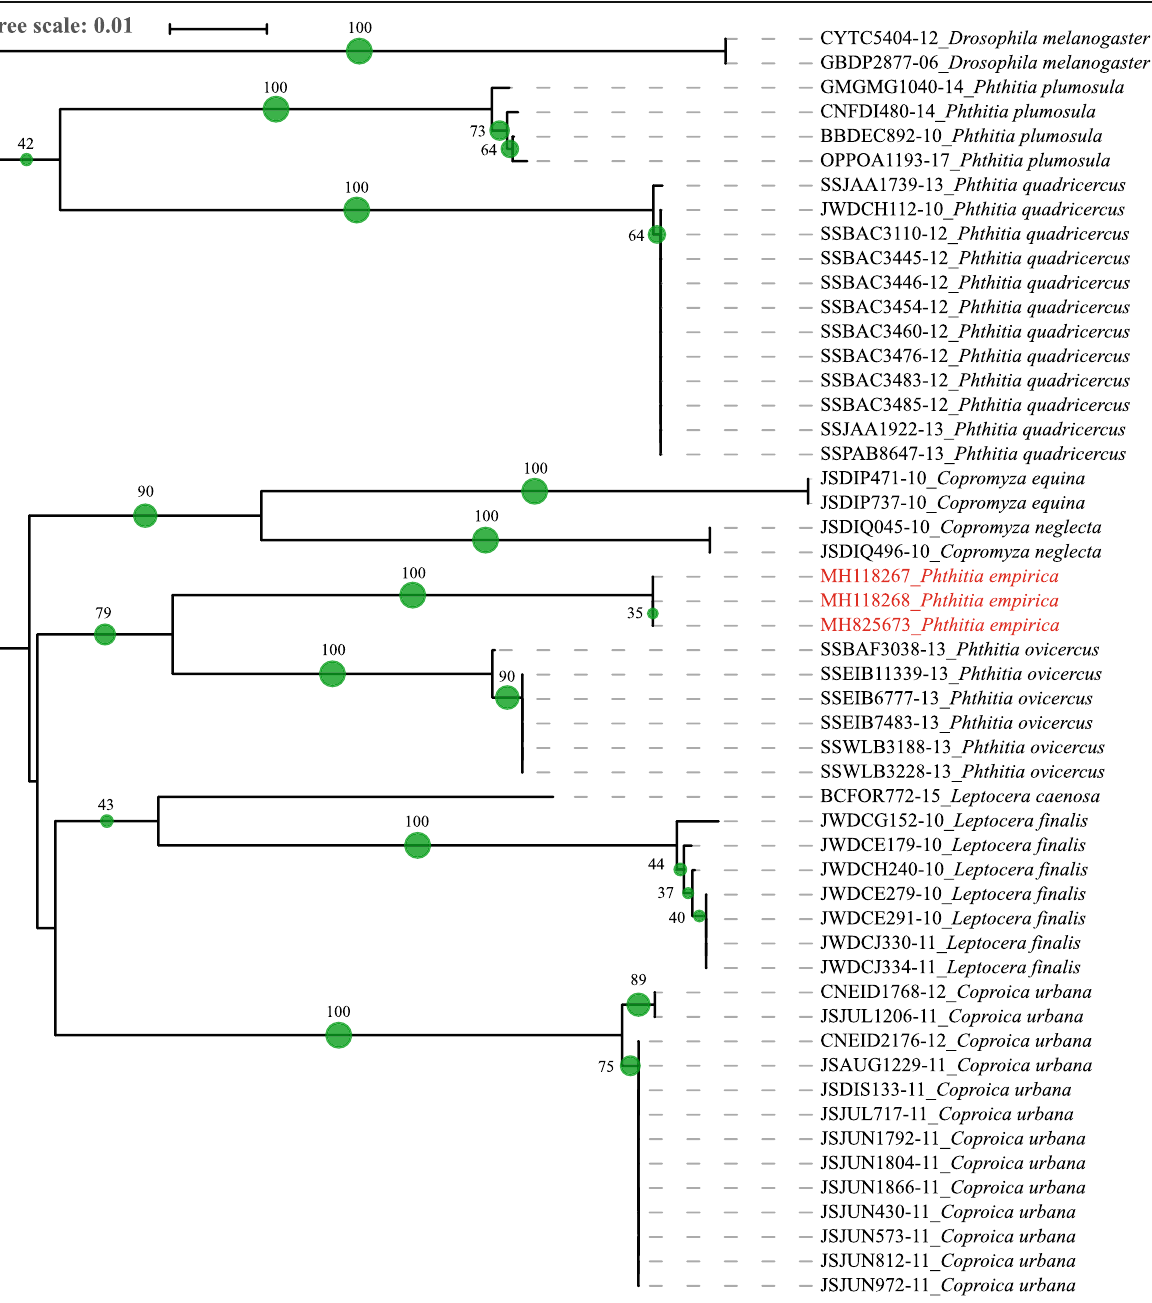
Fig. 4 Phylogenetic tree of Sphaeroceridae family. Neighbour Joining method analysis of 598 bp sequence of the COI gene. The green spots and the number at each node indicate the bootstrap support. Sequences from this study are reported in red. Sequences of Drosophila melanogaster were used as